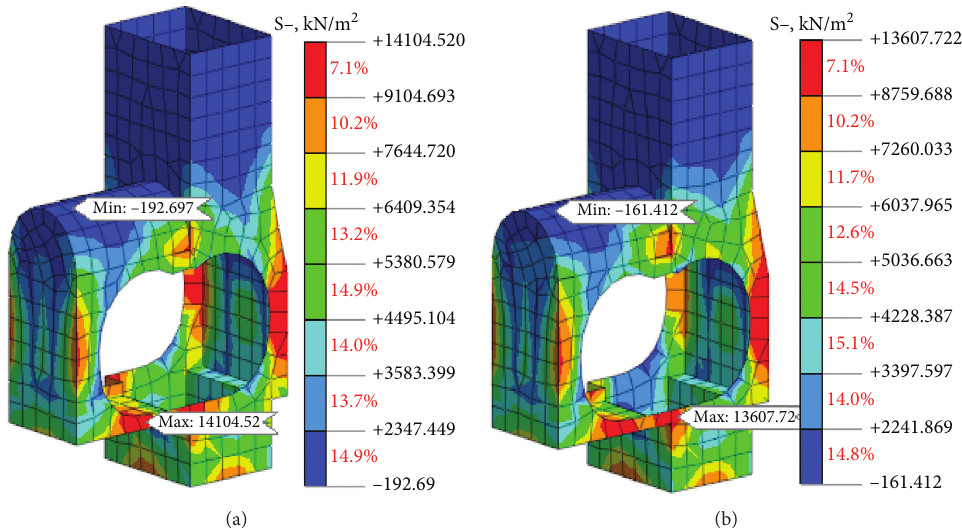
Figure 18: Distribution of main stress in the supporting structure of shaft transverse passage (unit: kN/m 2 ): (a) original scheme and (b) optimization schemes.